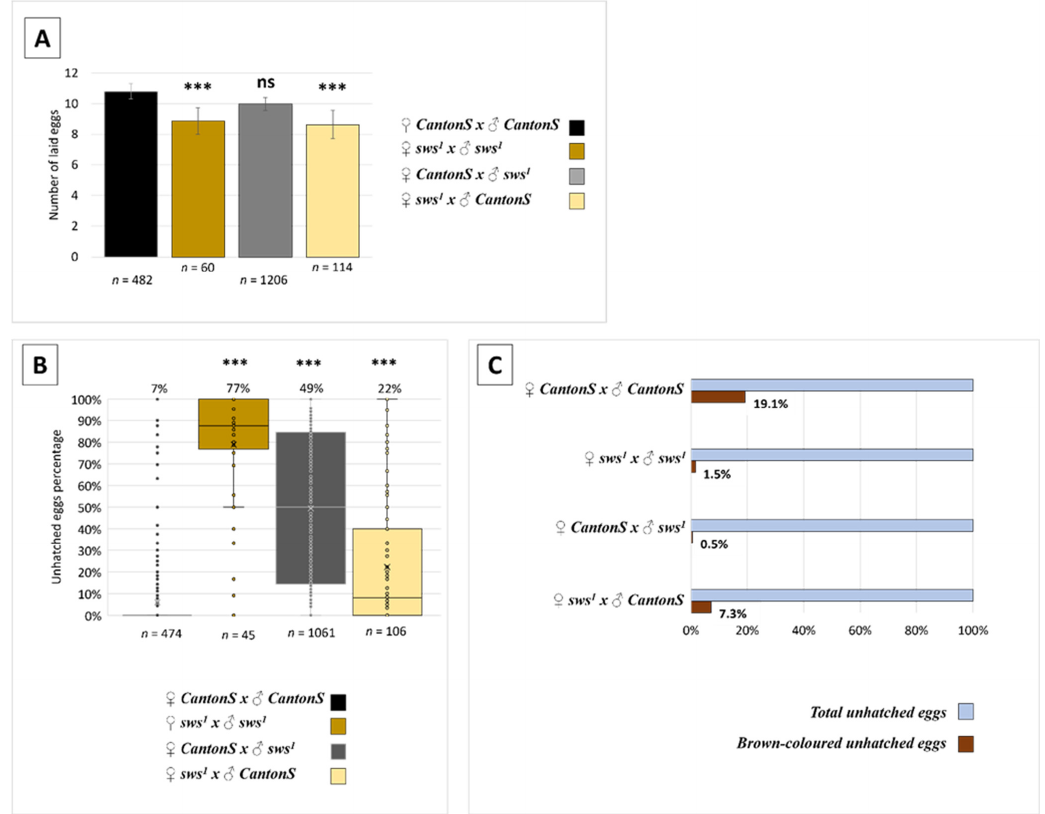
Figure 5. Analysis of fertility. ( A ) Female fecundity (number of eggs laid by 1 female per 24 h) in different crossings. Parents’ genotypes are written near the diagram. The sample size for each crossing is designated as n . The age of parents was equal, ranging from 3 to 10 days. Dunnett’s test; *** p < 0.001; ns—no significant difference ( p > 0.05). Note that the sws 1 mutant mothers laid fewer eggs than the respective controls. ( B ) Percentage of unhatched eggs laid by a normal/mutant female crossed with a normal/mutant male after 48 h of incubation of the clutch. The mean is written above each bar. Parents’ genotypes are written under the diagram. The sample size for each crossing is designated as n . The age of parents was equal, ranging from 3 to 10 days. Steel test; *** p < 0.001. Note that there are much more unhatched eggs in the progeny of mutant parents, and this phenotype is partially copied when even one of the parents is mutant. ( C ) Percentage of brown eggs among the total number of unhatched eggs in the progeny of flies in different crossings (brown colour indicates the egg was fertilized). Note that in the progeny of a mutant parent there are fewer brown unhatched eggs.